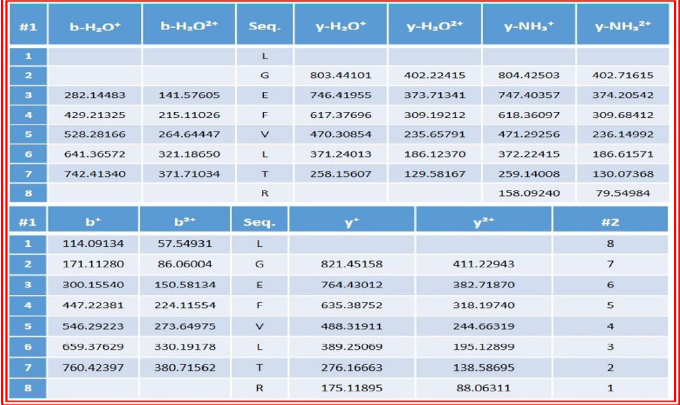
Figure 9. Ion table of spectra of chickpea peptide.